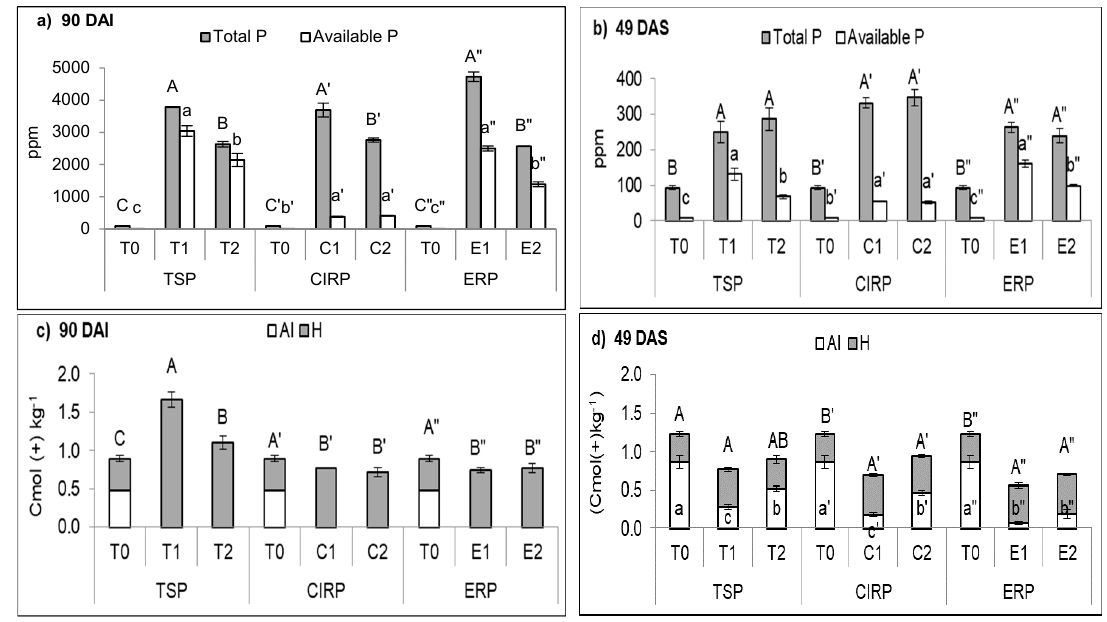
Figure 1. Effects of treatments on ( a ) soil total P and available P 90 days after incubation (DAI); ( b ) soil total P and available P at 49 day after seeding (DAS); ( c ) soil titratable acidity at 90 DAI, and ( d ) soil titratable acidity at 49 DAS. Means with a different letter indicate significant differences using Tukey’s test at p ≤ 0.05. Capital letters indicate titratable acidity, whereas small letters indicate H + . The error bars indicate the ± standard error of triplicate. Table 5. Selected chemical properties of soil at ninety days after incubation and forty-nine days after seeding. TSP